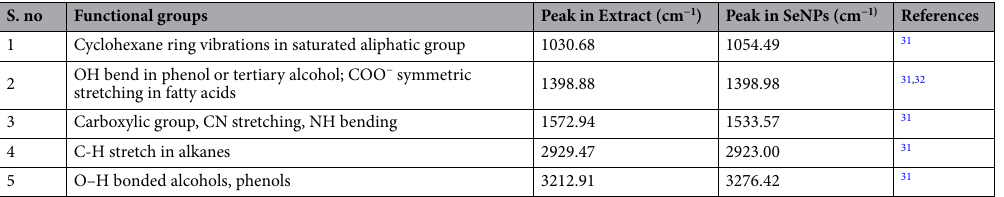
Table 2. FTIR Spectra of cell extract and B-SeNPs.